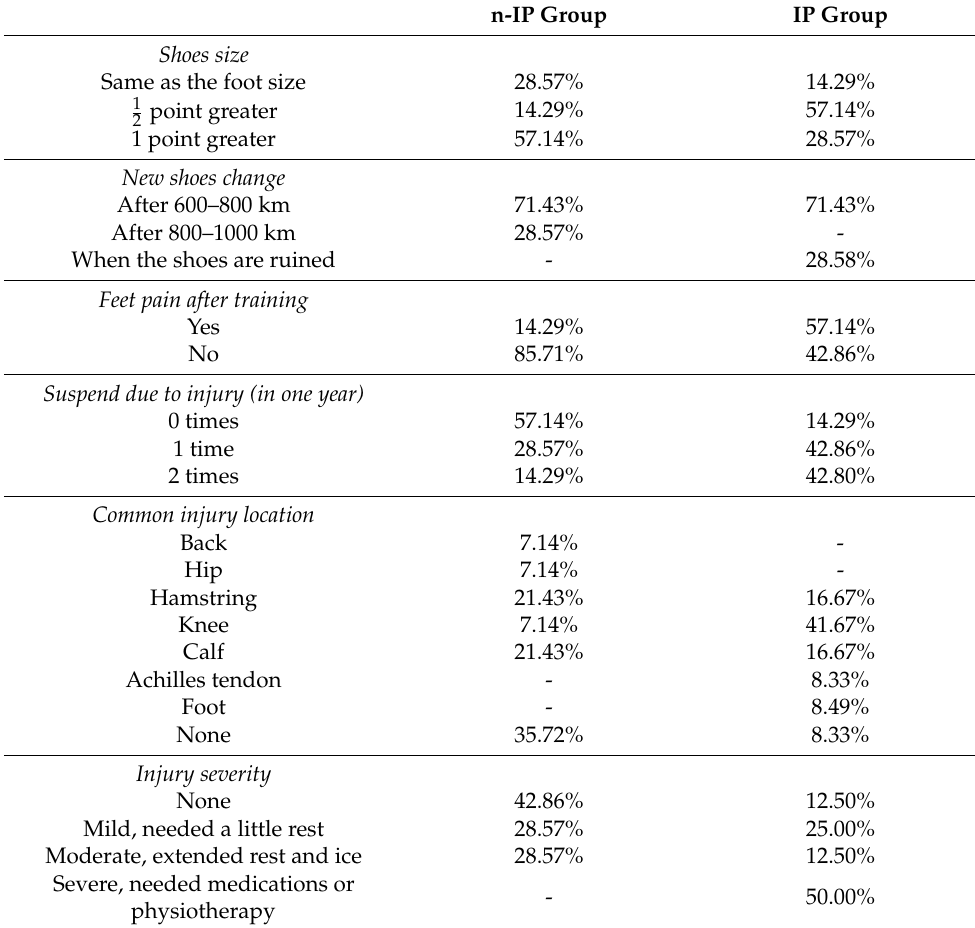
Table 4. Specific conditions related to footwear and the incidence of